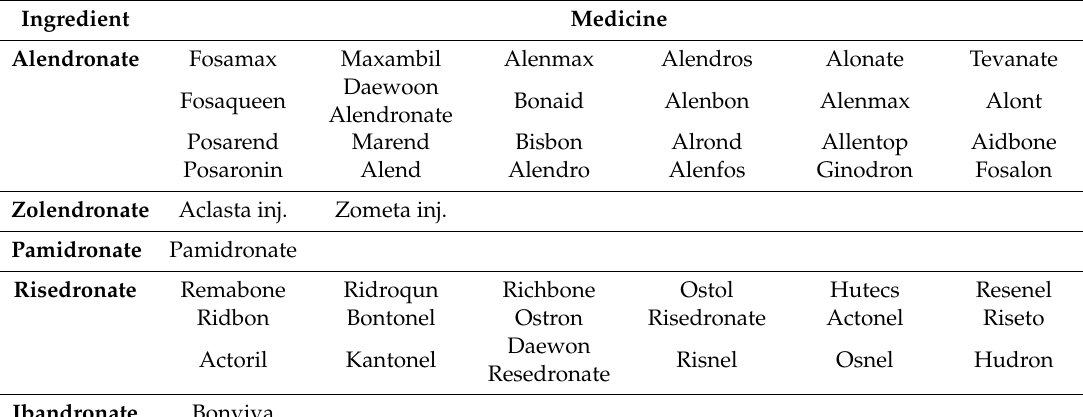
Table 1. Various Types of Bisphosphonates (BPs) according to the o ffi cial Name of